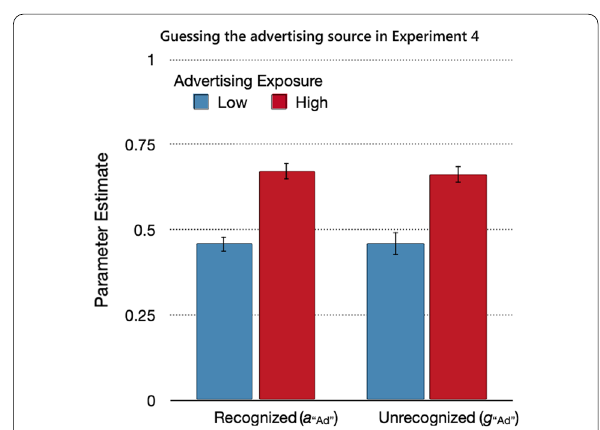
Fig. 11 Guessing the advertising source in Experiment 4. Note : Parameter estimates of the parameters reflecting the probabilities of guessing the advertising source for recognized ( a “Ad” ) and unrecognized ( g “Ad” ) statements as a function of advertising exposure (low, high). The error bars represent standard